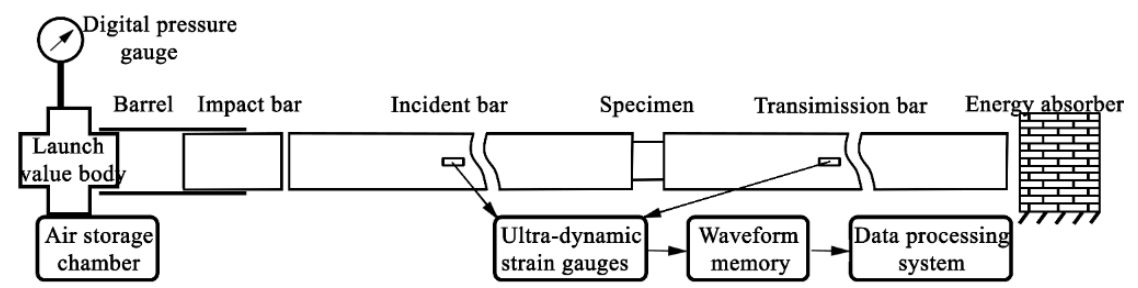
Figure 2. Split Hopkinson pressure bar experimental Figure 2. split Hopkinson pressure bar experimental devices.